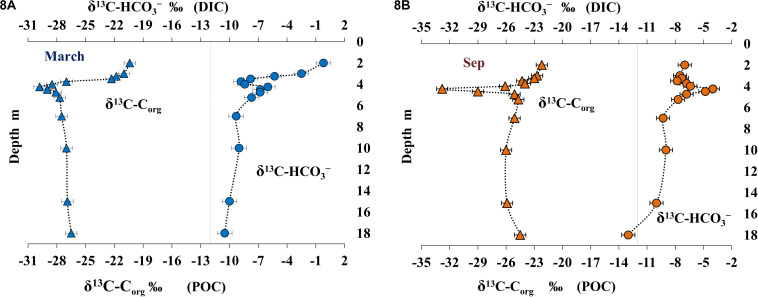
Isotope composition of particulate organic carbon (POC) (δ13Corg %) and dissolved inorganic carbon (DIC) (δ13C-HCO3, – %) in March (A) and September (B).